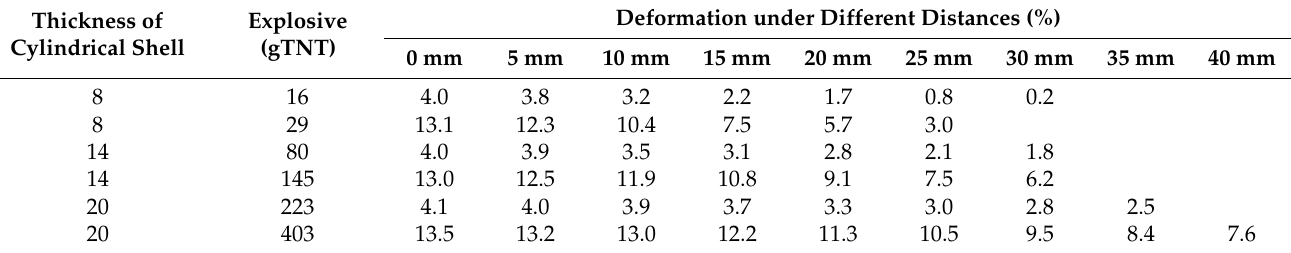
Table 4. The numerical simulation of 20# steel.